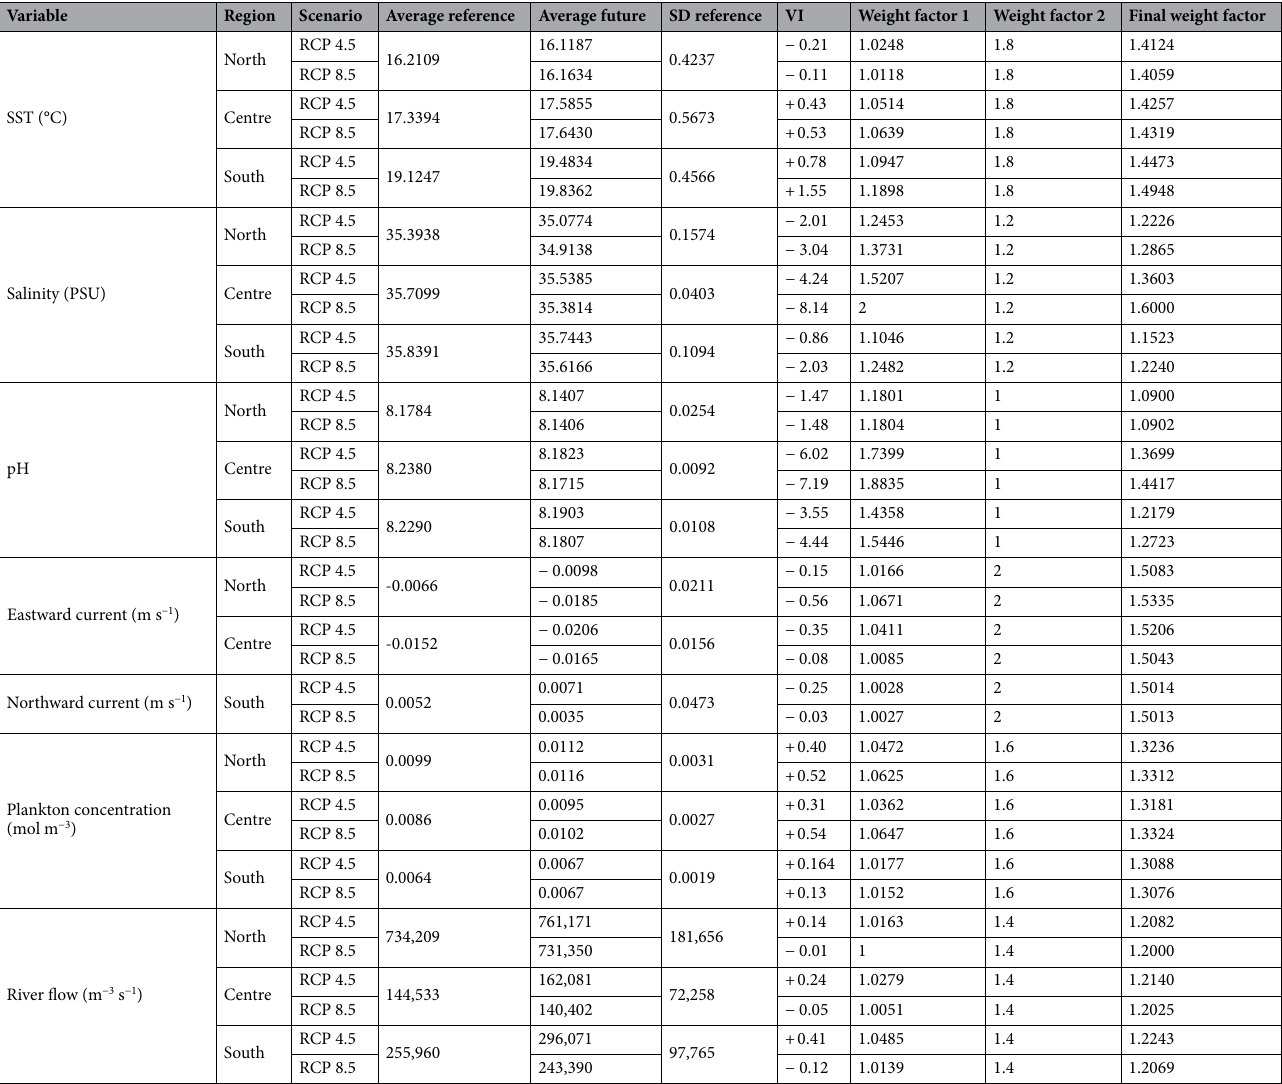
Table 2. Expected physical variability between 2000–2019 (reference) and 2040–2059 (future) according to POLCOMS-ERSEM physical-biogeochemical model. Outputs are shown considering three regions of Portugal (North, Centre, South) and two scenarios of climate change (RCP 4.5 and RCP 8.5). Weight factor 1 captures the degree of variability of the physical variables (see “Methods”). Weight factor 2 represents the likely impact on the physiology of the marine organisms and was obtained from the experts’ criteria. The final weight factor, used in the vulnerability assessment, is the average between weight factor 1 and